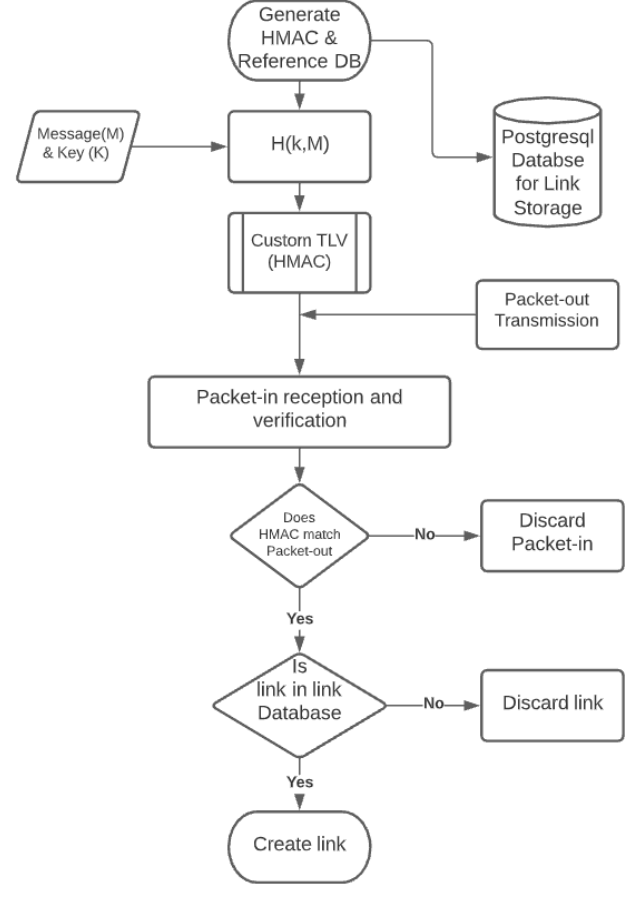
Figure 8. Proposed link fabrication mitigation algorithm